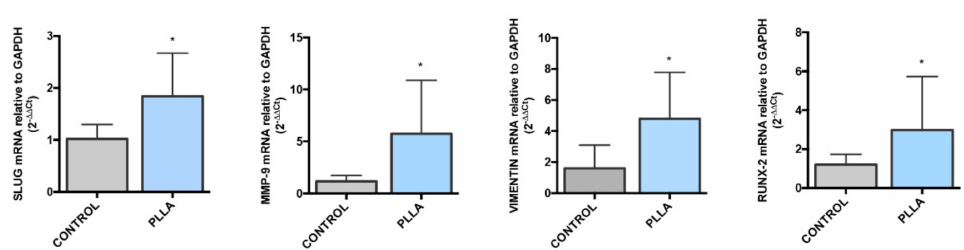
Figure 2. PLLA perturbs the End-MT and osteogenic phenotype in HUVEC. Gene expression analysis of SLUG, MMP-9, VIMENTIN and RUNX-2 performed by Real Time PCR in HUVEC after 48 h co-culture with PLLA. Results are reported as fold changes relative to HUVEC without PLLA (control HUVEC). All data are expressed as mean ± SD of at least 3 independent experiments, and statistical analysis was performed by unpaired Student’s t -test; *, p < 0.05. PLLA: poly-L-lactic acid; End-MT: endothelial to mesenchymal transition; HUVEC: human umbilical vein endothelial